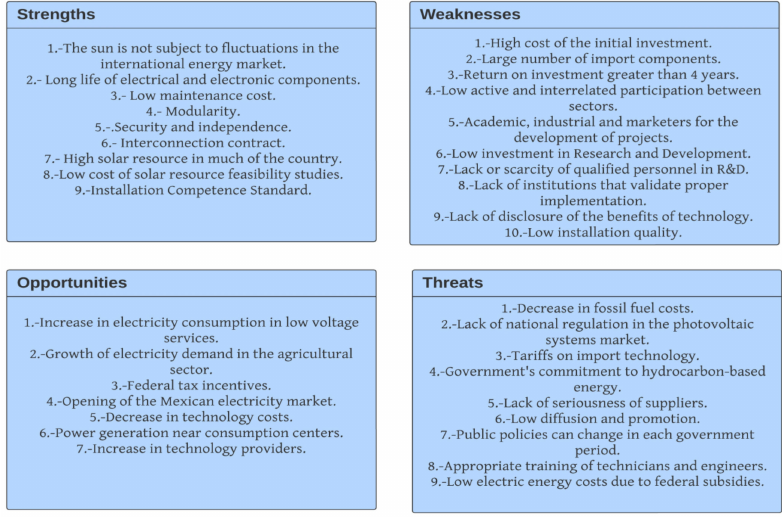
Figure 17. SWOT analysis of the implementation of photovoltaic systems in